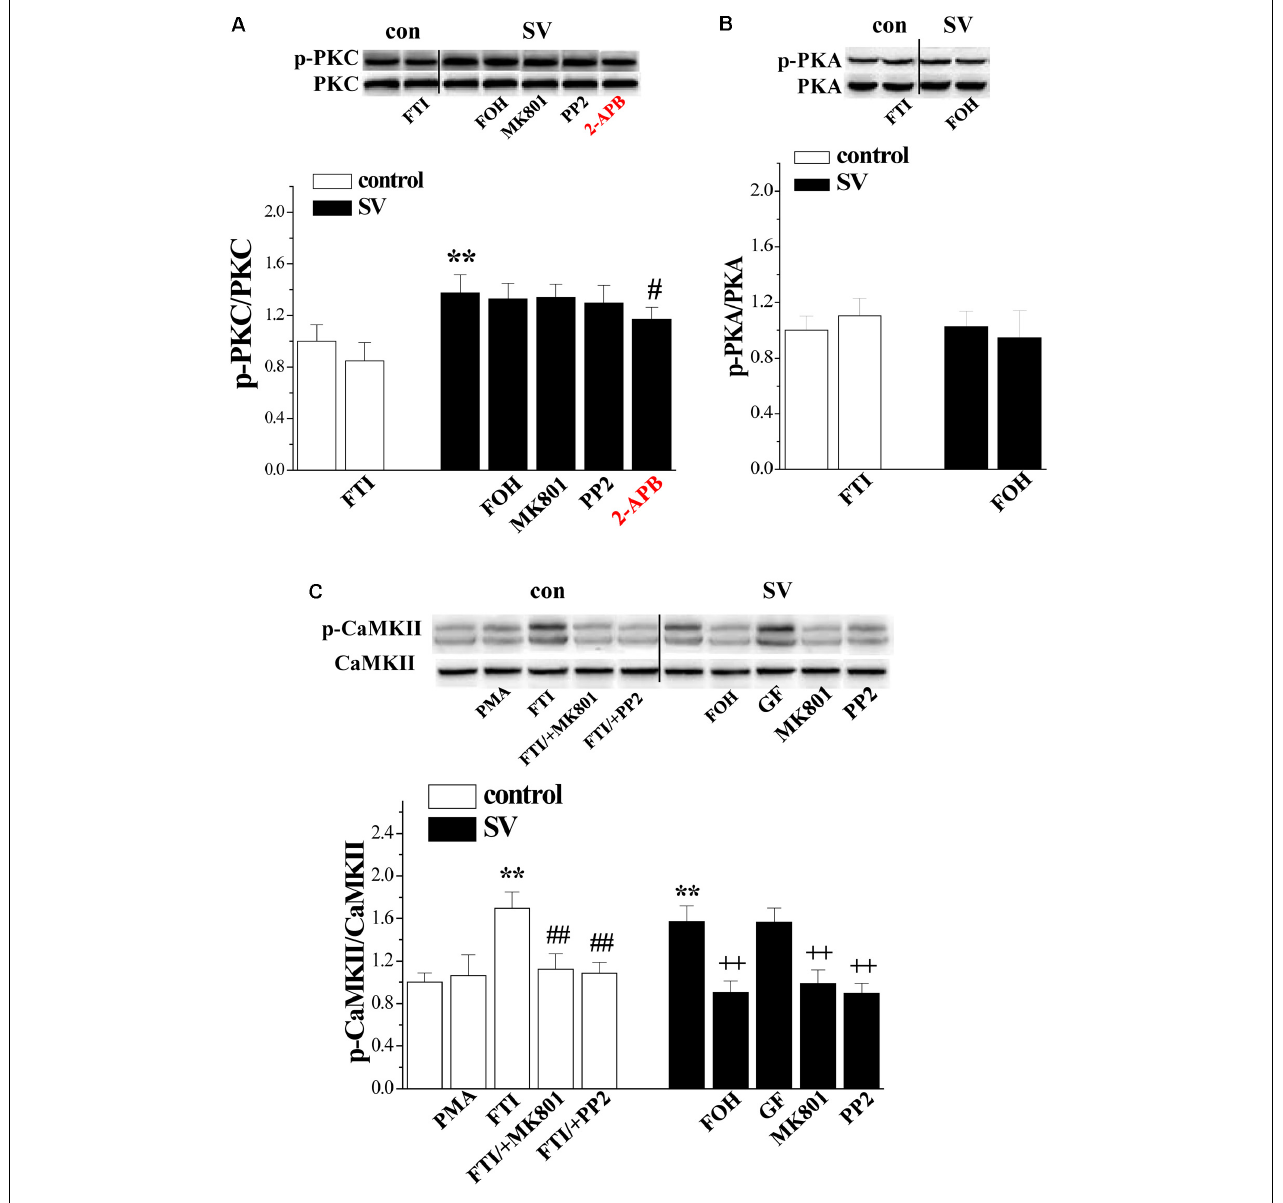
FIGURE 4 | Simvastatin cascades PKC and CaMKII signaling pathways. (A) Bar graphs show the levels of phospho-PKC in FTI-treated slices, SV/+FOH-, SV/+MK801-, SV/+PP2- and SV/+2-APB-treated slices. ∗∗ p < 0.01 vs. control slices; # p < 0.05 vs. SV-treated slices. (B) Bar graphs show the levels of phospho-PKA in FTI-treated slices, SV/+FOH-treated slices. (C) Bars represent the levels of phospho-CaMKII in PMA- or FTI-treated slices, FTI/+MK801- or FTI/+PP2-treated slices, SV/+FOH-, SV/+GF-, SV/+MK801- and SV/+PP2-treated slices. ∗∗ P < 0.01 vs. control slices; ## p < 0.01 vs. FTI-treated slices; ++ p < 0.01 vs. SV-treated slices (two-way